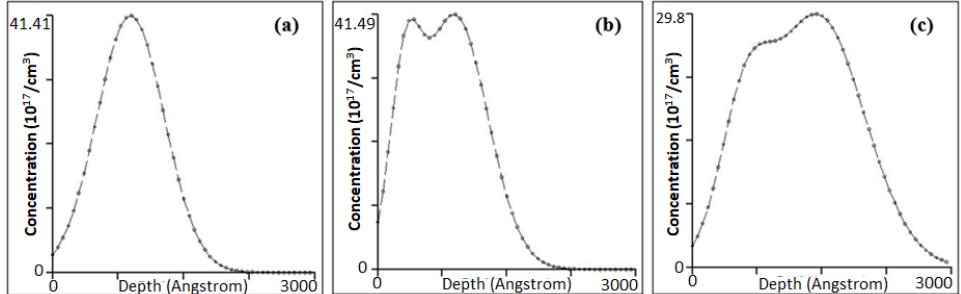
Figure 5. Carbon implant profile from SUSPRE simulation for ( a ) sample B, ( b ) sample C and ( c ) sample D. Sample B is implanted with 30 keV of carbon, whereas samples C and D are double implanted with 30/10 keV and 50/20 keV of carbon, respectively.